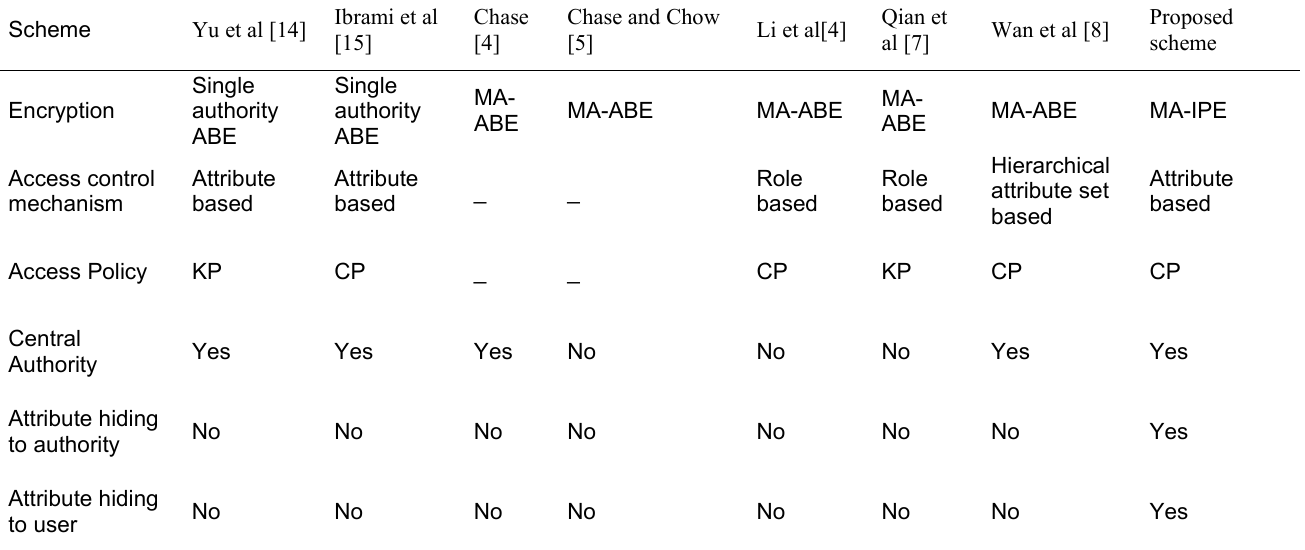
Table 1. Comparing proposed system with similar